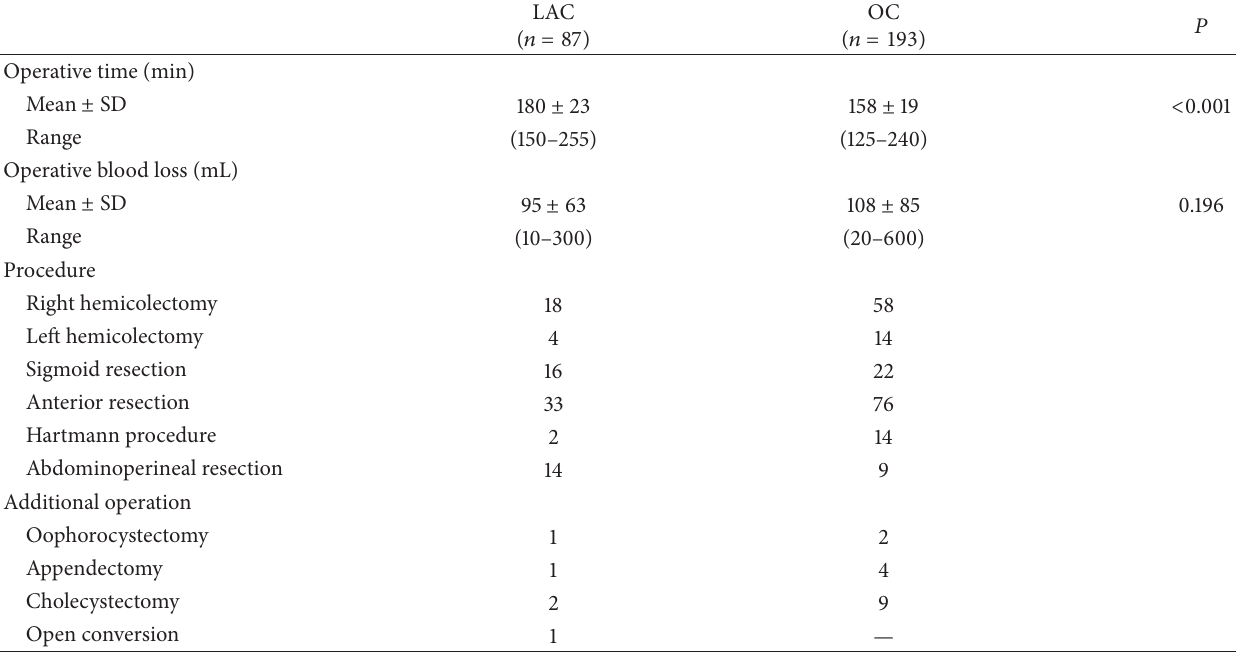
Table 2: Perioperative